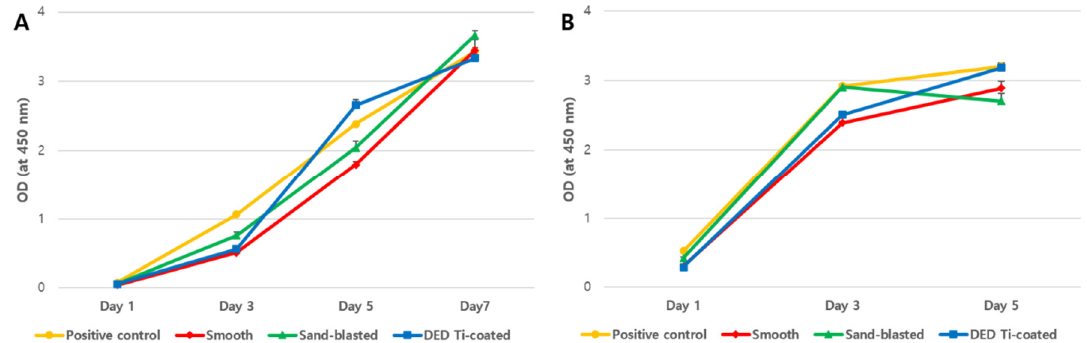
Figure 5. Results of CCK-8 assay for each specimen at the time flow using low ( A : 3 × 10 3 cells) and high ( B : 1.2 × 10 4 cells) concentrations of cells. In the DED group, unlike that in the other groups, the osteoblast viability increased rapidly between from day 3 to 5. (OD: optical density, DED: direct energy deposition)